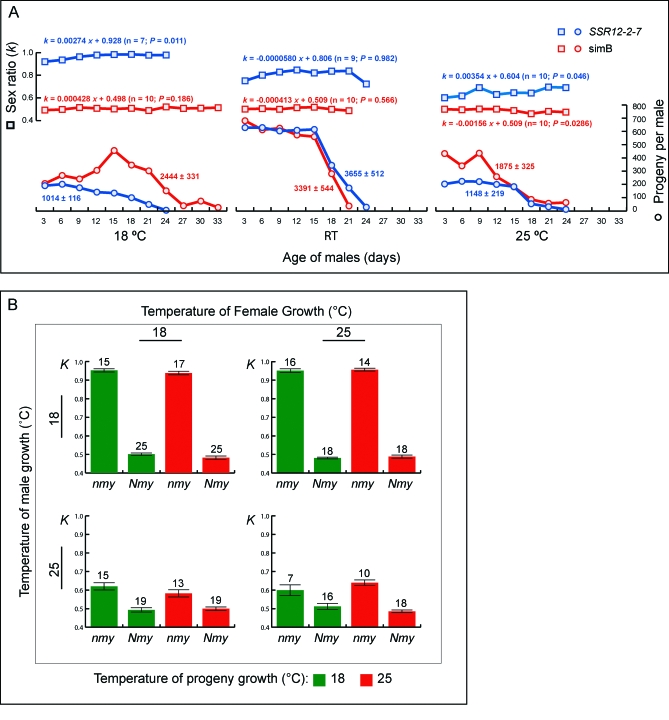
The Expression of sex-ratio Is Temperature Sensitive during Spermatogenesis(A) The expression of sex-ratio is temperature sensitive. The sex ratio and size of progeny of SSR12-2-7 nmy or simB Nmy (control) males at various ages are shown. “Sperm exhaustion” experiments were done at three temperatures: 18 (± 0.5)°C, room temperature (22 ± 1.0°C), and 25 (± 0.5)°C. Every 3 d, single SSR12-2-7 nmy or simB Nmy males were provided with three w; e virgin females, and the mated w; e females were transferred to fresh vials. The procedure was repeated until the females were no longer fertile. In this fashion, progeny number (mean ± SEM per male) serves as a proxy for the number of functional sperm. The overall sex ratio (k) trend with age (x) is also shown (k = ax + b; n = males tested; p = significance test for the hypothesis a = 0). A significant age effect on sex-ratio was detected at all three temperatures (k = 0.00383x + 0.771; p = 0.046 for SSR12-2-7 nmy at room temperature if the last data point is excluded). The expressivity of sex-ratio is inversely correlated with the temperature. SSR12-2-7 nmy males were as fertile as simB at room tempreature and 25 °C (t-test, p = 0.729 and 0.08, respectively), but they were significantly lower in fertility at 18°C (p = 0.002).(B) The temperature sensitivity of sex-ratio is restricted to spermatogenesis. In this “temperature combination” experiment, pairs of 2-d-old virgin males (SSR12-2-7 nmy or simB Nmy) and females (w; e), reared at either 18 °C or 25 °C, were monitored for copulation up to 8 h at room temperature (22 ± 1 °C). Immediately after copulation, the male was aspirated away while the female was cultured at either 18 °C or 25 °C. These mated females were transferred to fresh vials every 3 d until the females became sterile. Seven to 25 males were tested for each of the 16 combinations of factors (genotype and temperature). The results (sex-ratio ± SEM) are shown as columns, and error bars with the sample sizes are also indicated. A generalized linear model was used for analysis of variance (SAS PROC GENMOD). Only the temperature at which males were reared had a significant effect on the observed sex-ratio (p < 0.0001), while the other two temperatures at which the females and the progeny were reared have no effect (p = 0.5703 and 0.3021, respectively).